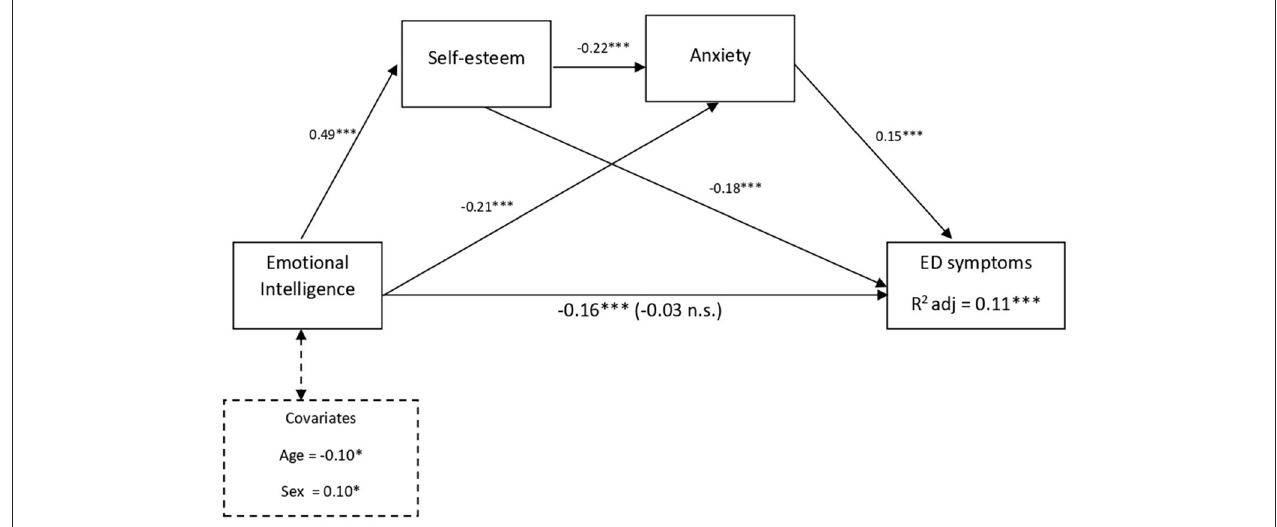
FIGURE 1 | Multiple mediation model for the effect of EI and ED symptoms via self-esteem and anxiety controlling for age and sex as covariates. Total effect (c-path) is given in parentheses; standardized coefficients; * p < 0.05; *** p <